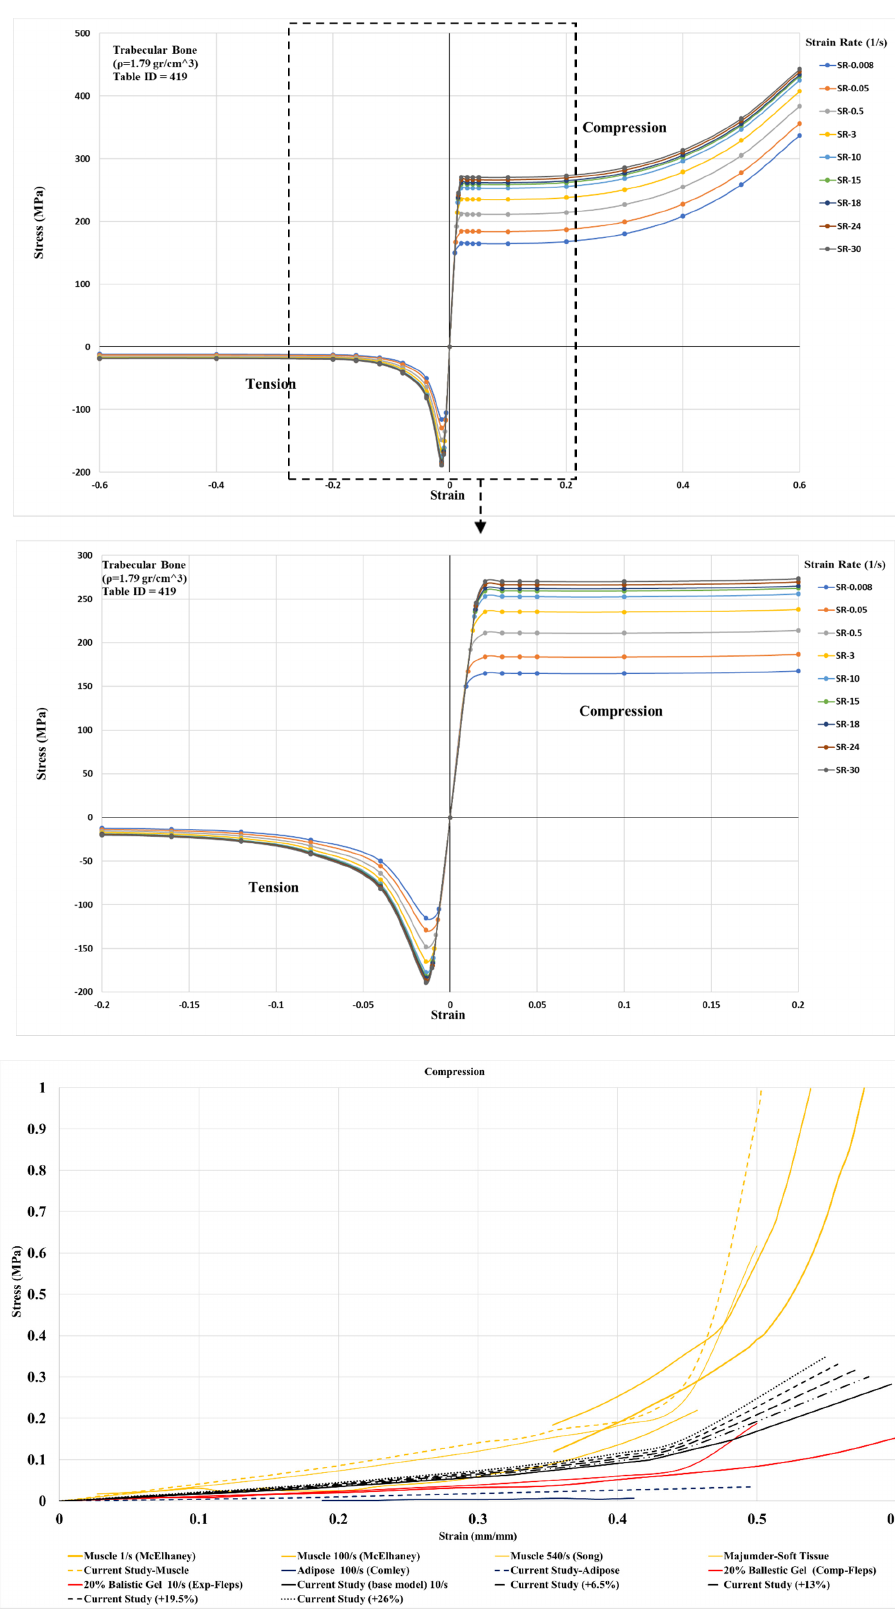
Figure A7. Stress–strain response of various experimental and computational models for the trochanteric soft tissue.